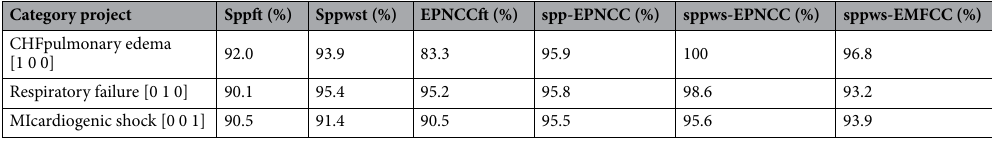
Table 6. Precision of each training category.